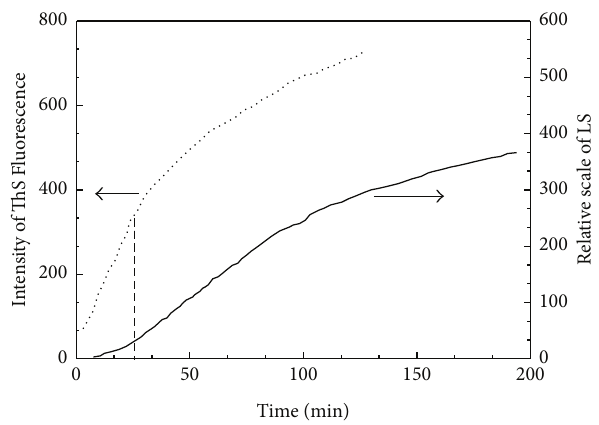
Figure 2: Comparison of light scattering (solid line) with ThS fluorescence assay (dotted line) for monitoring the accumulation of